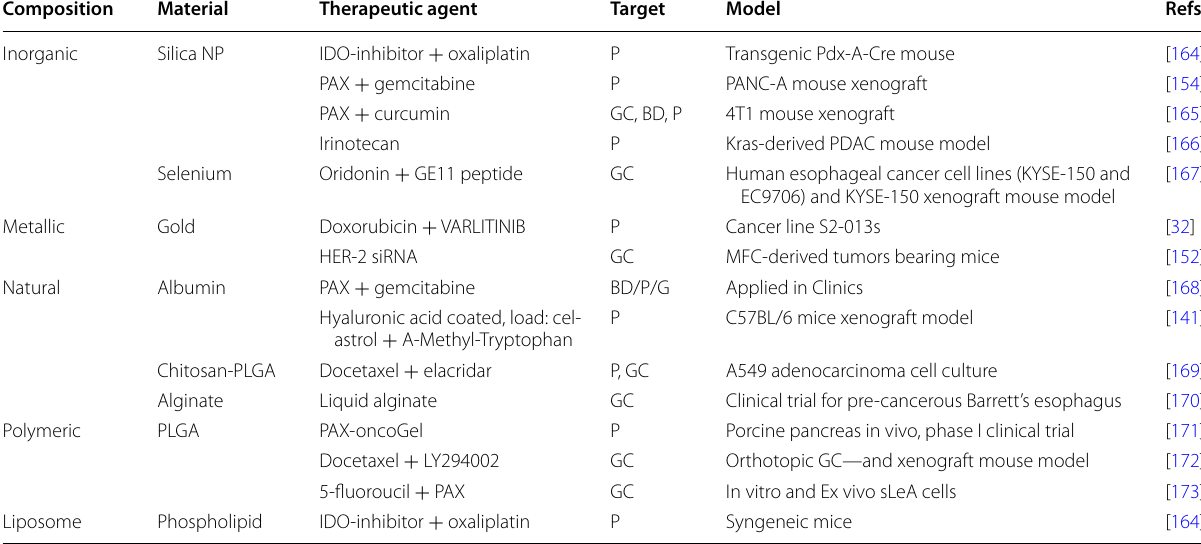
P pancreas, BD bile duct, GC gastric/esophageal